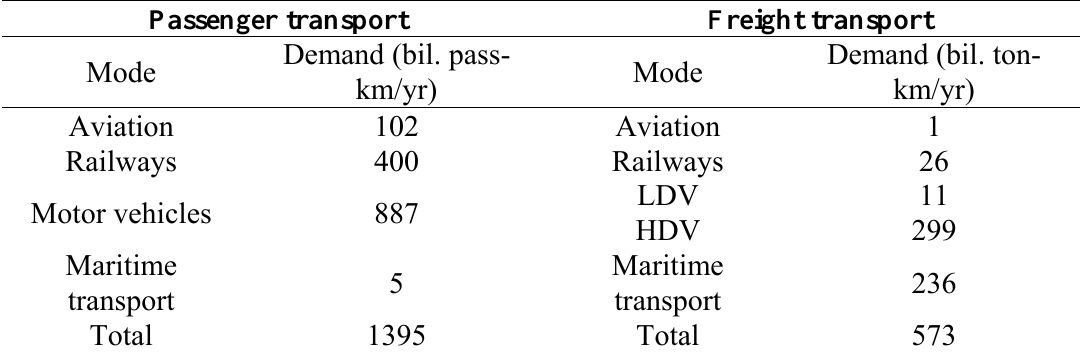
Table 6. Assumed transport demand in BAU scenario (Japan as a whole, 2030)